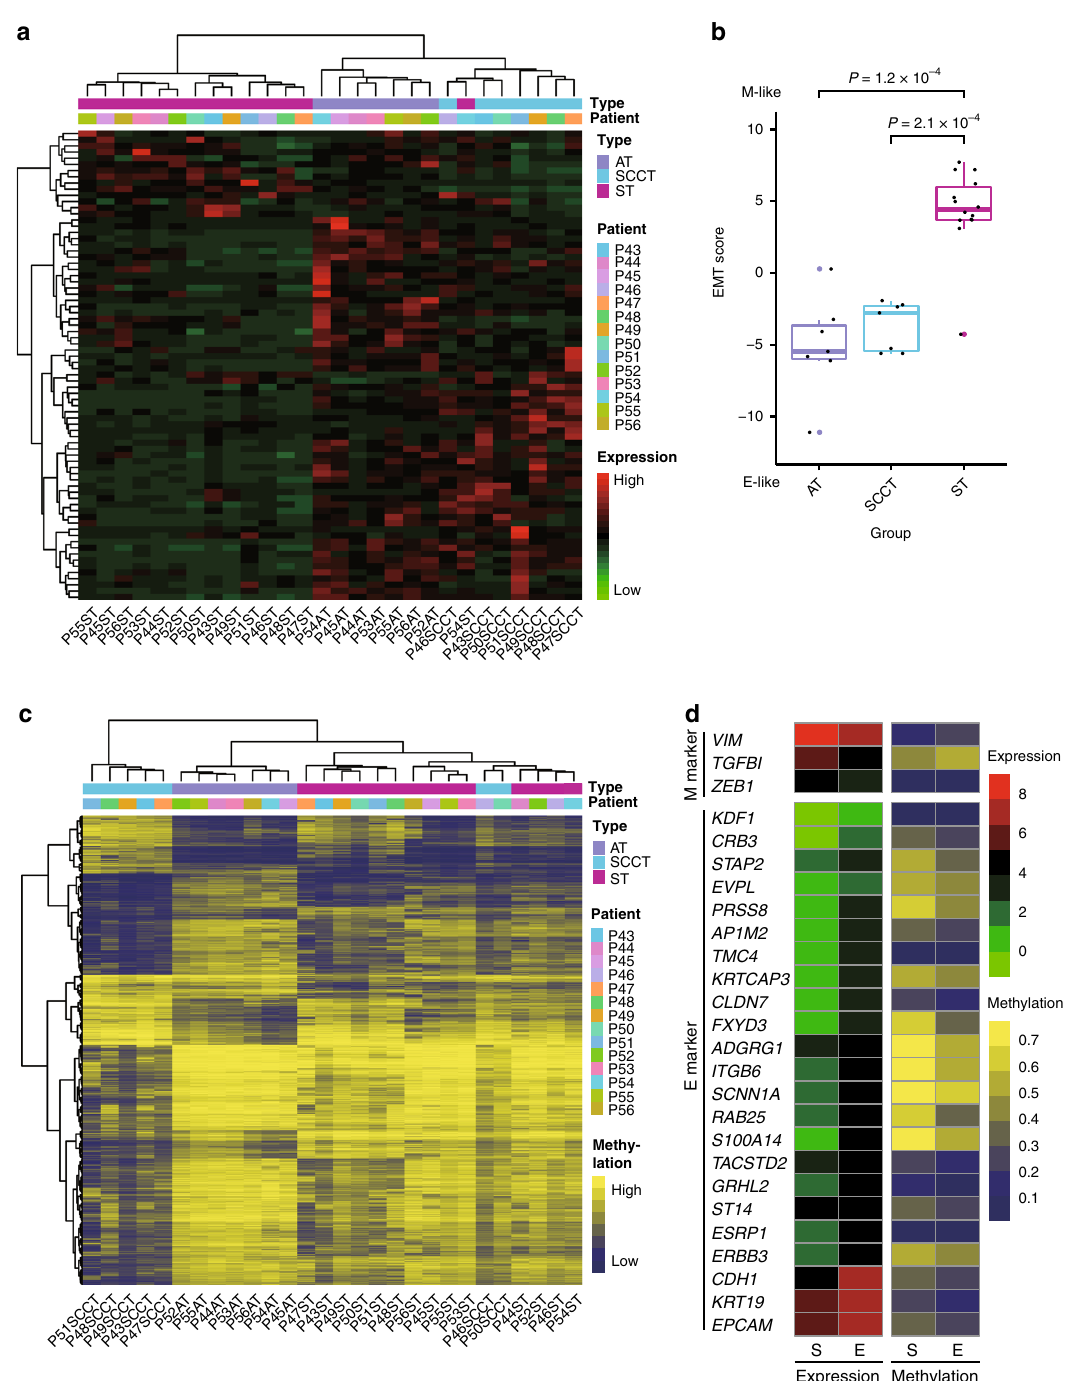
Fig. 3 Transcriptional and DNA methylation pro fi les of the epithelial and sarcomatoid components. a The heatmap of hierarchical clustering with the expression level of a 76-gene EMT signature, annotated for the histological type and the patients. AT, adenocarcinoma component; SCCT, squamous cell carcinoma component; ST, sarcomatoid component. Source data are provided as a Source data fi le. b EMT scores are plotted for adenocarcinoma (AT), squamous cell carcinoma (SCCT), and sarcomatoid (ST) components as boxplots. Center line, median; box limits, upper and lower quartiles; whiskers, 1.5× interquartile range; colored points, outliers. Two-sided Wilcoxon rank-sum test was used for statistical analysis. No P -value adjustment was applied. n = 7, 7, and 14 for AT, SCCT, and ST group, respectively. Source data are provided as a Source data fi le. c The heatmap of hierarchical clustering with DNA methylation data of the epithelial and sarcomatoid components, annotated for the histological type and the patients. AT, adenocarcinoma component; SCCT, squamous cell carcinoma component; ST, sarcomatoid component. d The mean expression levels and DNA methylation levels of the 26 genes in the epithelial and sarcomatoid components. M (mesenchymal) markers and E (epithelial) markers are displayed in the upper and lower panel, respectively. S and E in the bottom represent sarcomatoid and epithelial components. Source data are provided as a Source data fi